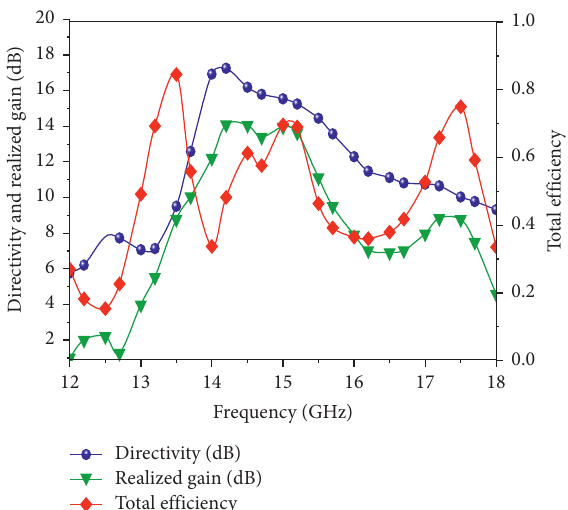
Figure 6: Variation in directivity, gain, and efficiency of the proposed antenna versus frequency.